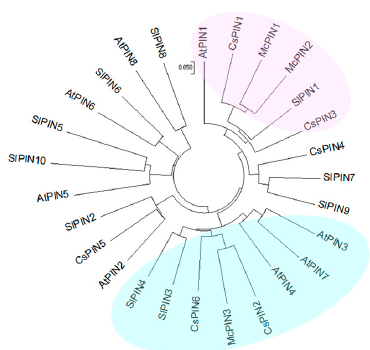
Figure 2. Amino acid sequence-based dendrogram among auxin efflux carriers from bitter gourd (McPIN1 to 3), cucumber (CsPIN1 to 6), and tomato (SlPIN1 to 10). GenBank accession numbers are AF247004 (McPIN1), AF246995 (McPIN2), AF247005 (McPIN3), AB085897 (CsPIN1), AF539049–AF539053 (CsPIN2 to 6), and HQ127074–HQ127083 (SlPIN1 to 10). Amino acid sequences were aligned using the AlignX program of Vector NTI Suite 10.0 software. Phylogenetic analysis was performed with the Neighbor-Joining program in Vector NTI Suite 9.0 software and output as circle by MEGA 7.0 package ([23], http://www.megasoftware.net). Scale bar indicates the number of amino acid substitutions per site.